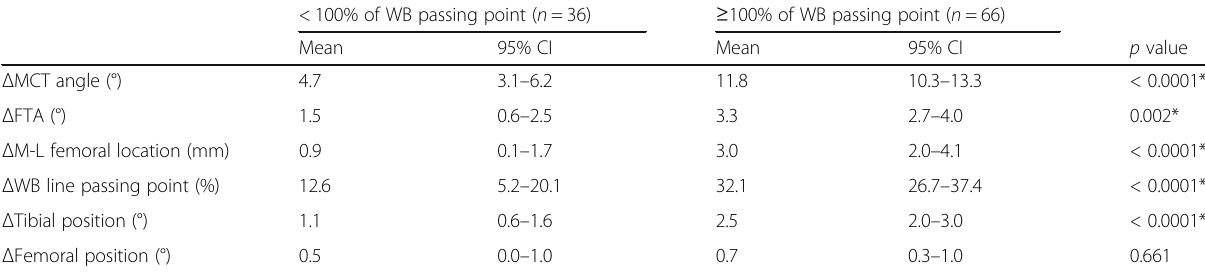
Table 3 Evaluation parameters of the groups categorized with 100% of WB passing point in WB condition